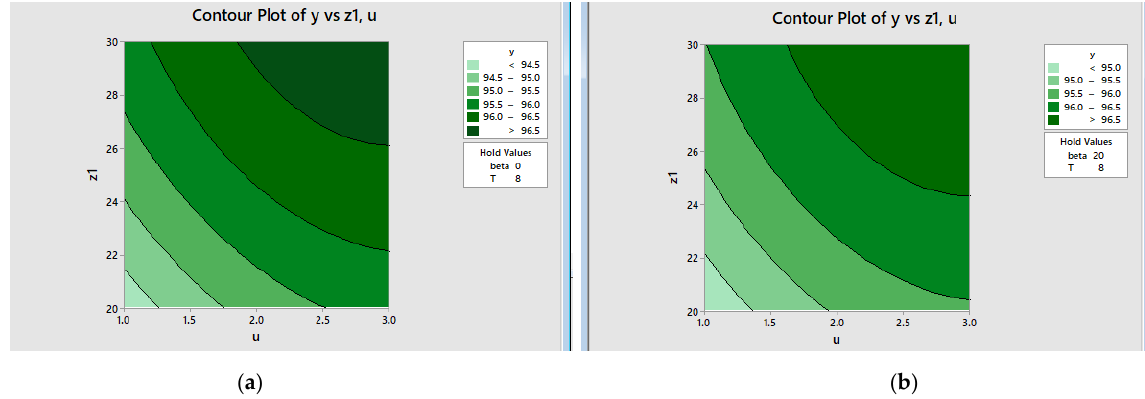
Figure 3. Contour plots of the efficiency of helical gear dependent on ratio u and number of teeth z 1 : ( a ) gear data: β = 0 and T = 8 N ∙ m; ( b ) gear data: β = 20° and T = 8 N ∙ m.